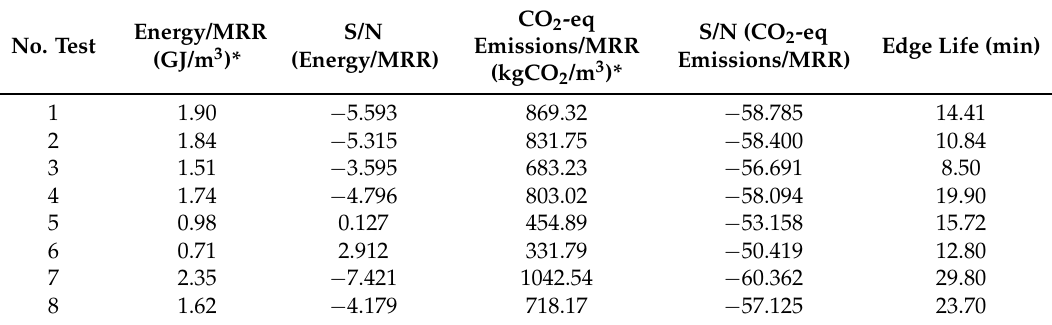
Table 6. Calculated energy/MRR, CO 2 -eq emissions and edge